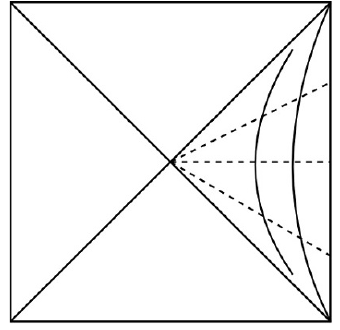
Figure 5. Penrose diagram of the de Sitter space. The right triangle region is one of the static patches. The solid curved lines represent static observers. The dashed lines are spatial slices of constant static time in the static